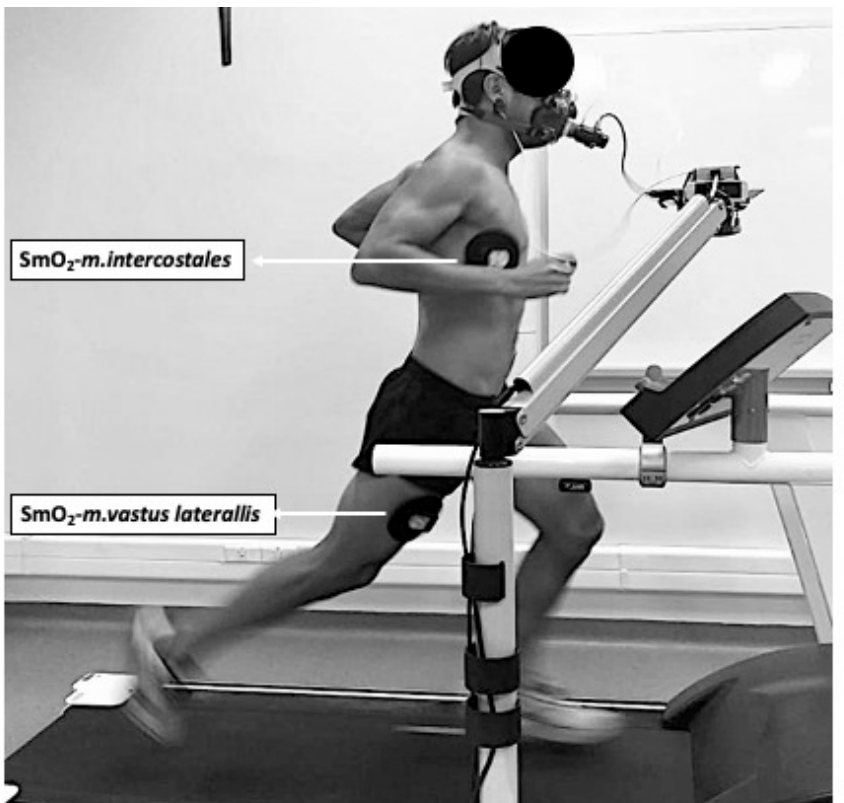
Figure 1. Placement of the muscle oximetry NIRS devices in the thorax ( m.intercostales ) and leg ( m.vastus laterallis ).